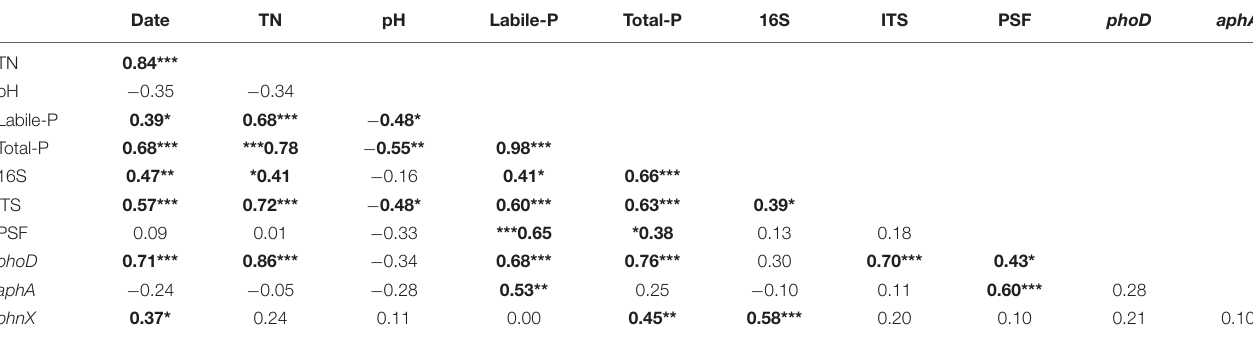
TABLE 5 | Spearman’s correlations (rs) between theoretically selected significant chemical and microbiological compost parameters. TN pH Labile-P Total-P 16S ITS PSF phoD